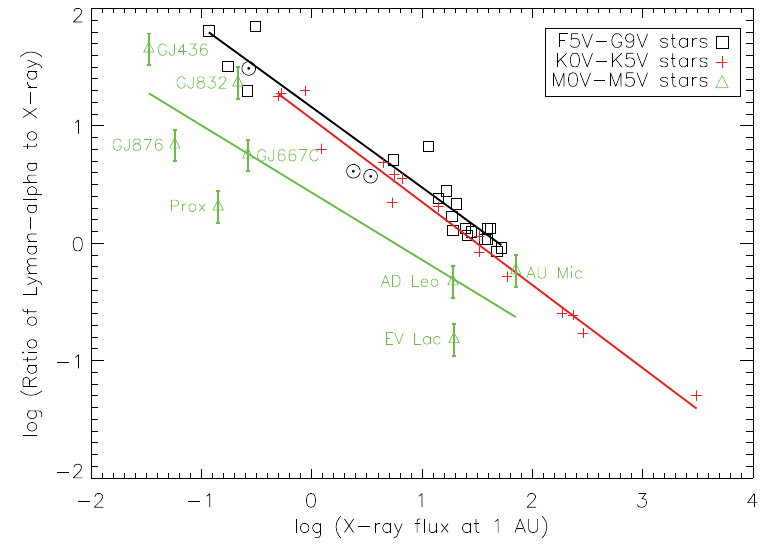
Figure 9. Same as Figure 8 except that stellar Lyman- α fluxes are compared to X-ray fluxes vs . X-ray flux at 1 AU. Note the tight correlations for F–K stars. Figure from Linsky et al .